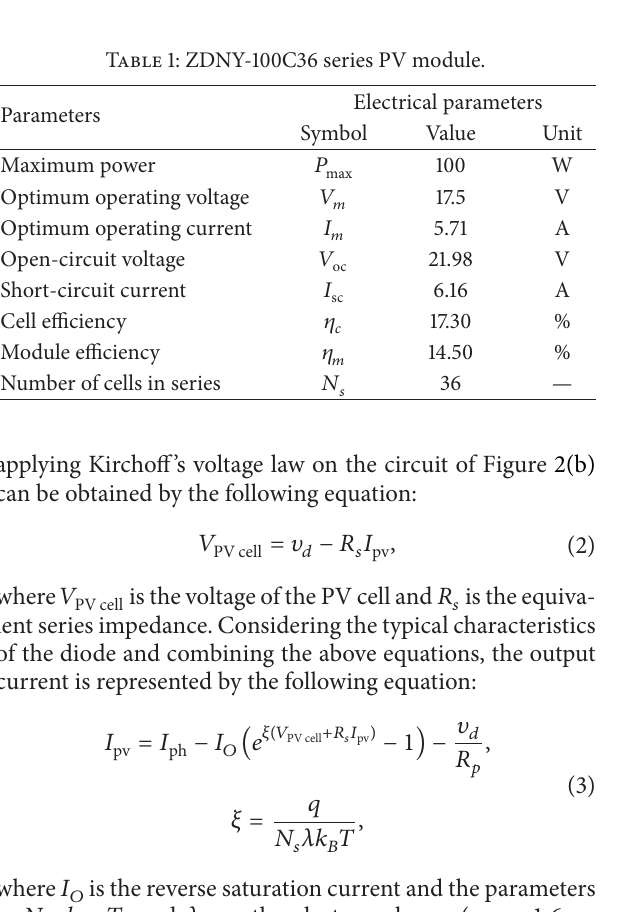
(b) Model based on a double-diode Figure 2: Equivalent circuit of the PV cell.